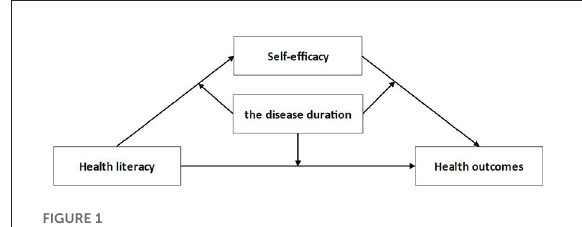
FIGURE1 The proposed moderated mediation